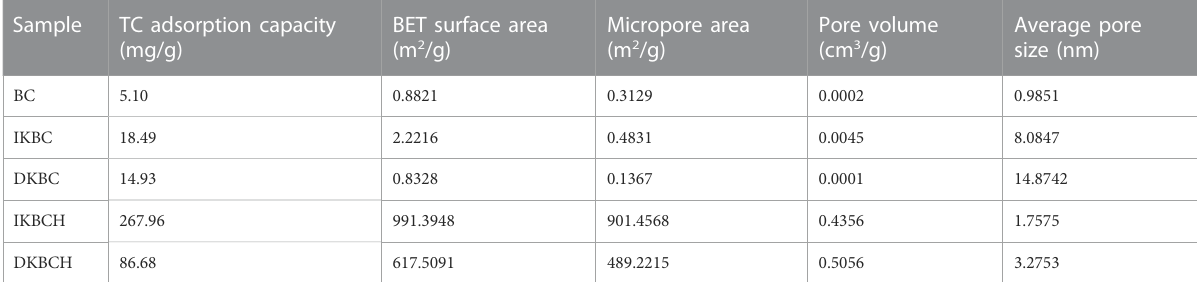
TABLE 2 TC adsorption capacity and textural properties of